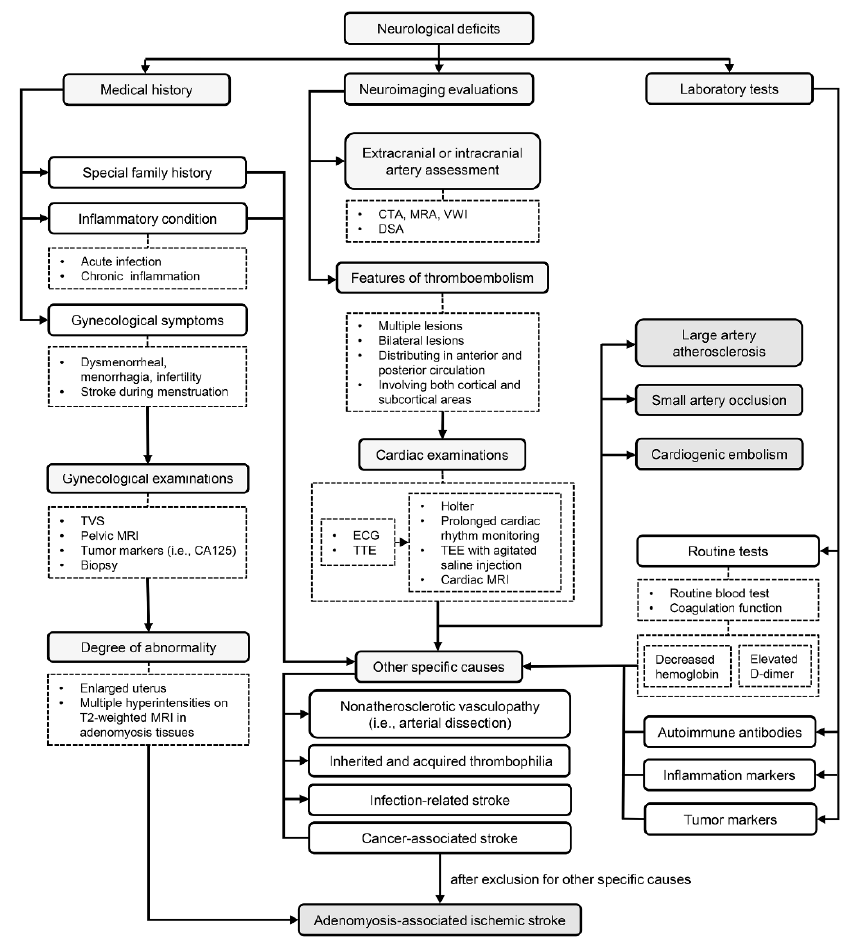
Figure 2. A diagnostic flow chart of adenomyosis-associated ischemic stroke. Medical history of gynecological symptoms, neuroimaging features of thromboembolism and laboratory test results of increased D-dimer, elevated CA125 and decreased hemoglobin are pivotal clues in disease recognition. Large artery atherosclerosis, small artery occlusion, cardiogenic embolism and some other specific causes should be carefully excluded. Abbreviation: TVS: transvaginal ultrasonography; MRI: magnetic resonance imaging; CA125: carbohydrate antigen 125; CTA: computerized tomography angiography; MRA: magnetic resonance angiography; VWI: vessel wall imaging; DSA: digital subtraction angiography; ECG: electrocardiograph; TTE: transthoracic echocardiography; TEE: transesophageal